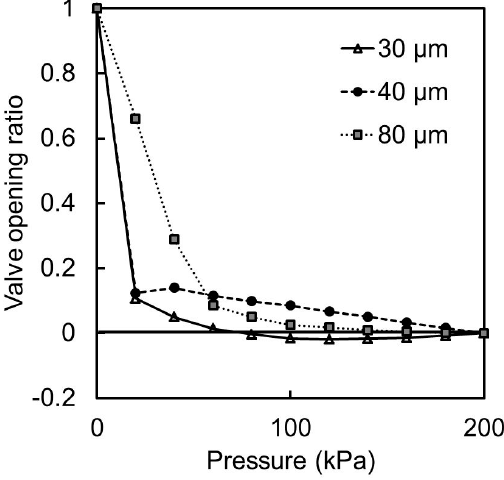
Figure 10. Normalized microvalve opening ratio as a function of the applied pressure for membrane thicknesses of 30, 40, and 80 μ m.